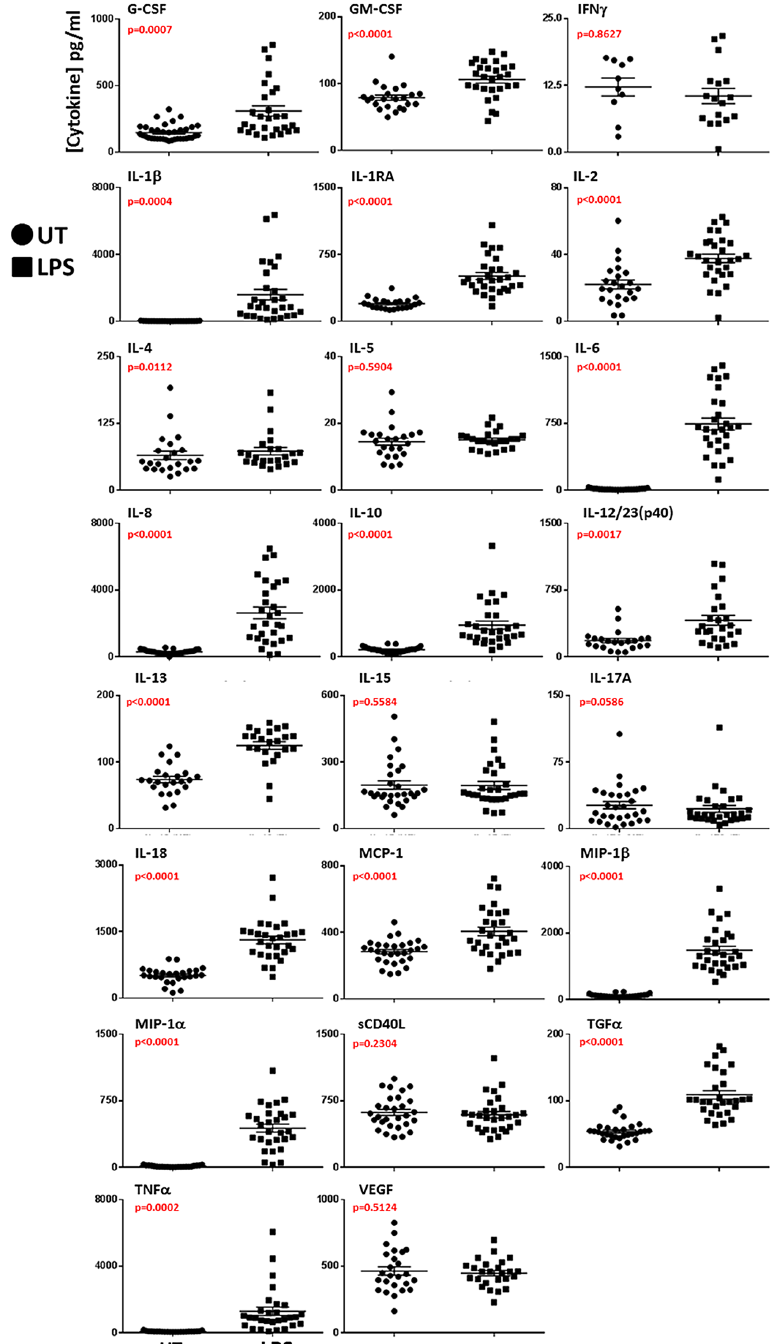
Fig 1. Cytokine secretion in response to LPS stimulation in Rhesus Macaque whole blood. Scatter plots depicting the individual responses (pg/ml) in each of the 23 cytokines measured in Rhesus Macaque whole blood stimulated with 100ng/ml LPS for 24 hours or not (UT). Cytokines were assayed by multiplex analysis of plasma supernatant.